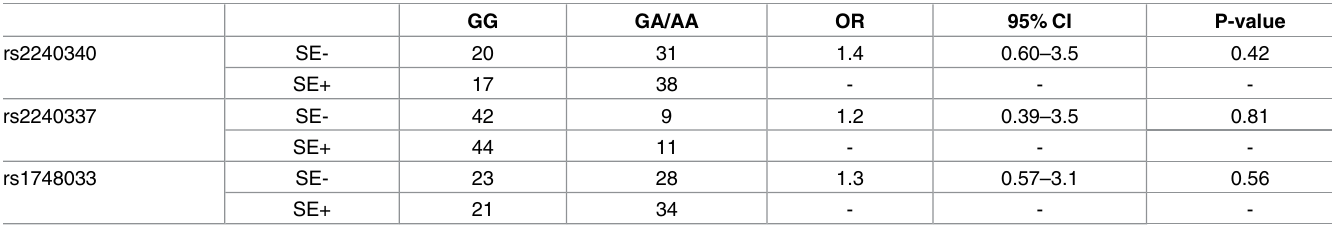
Table 5. Association between PADI4 gene polymorphisms and SE positivity in oligo- and poly- articular JIA (n = 106). GG